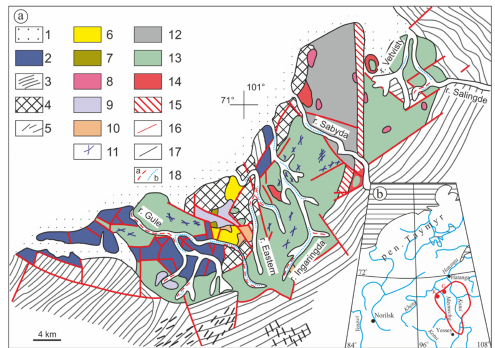
Figure 1. ( a ) Geological map of the Guli volcanic–plutonic complex. Compiled based on the ma- terials of L.S. Yegorov and G.G. Lopatin with clarifications and simplifications by O.M.